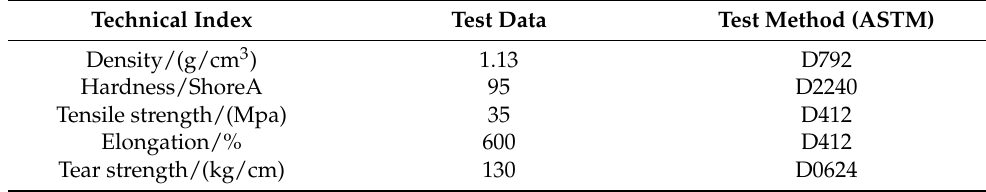
Table 2. The basic performance index of TPU.